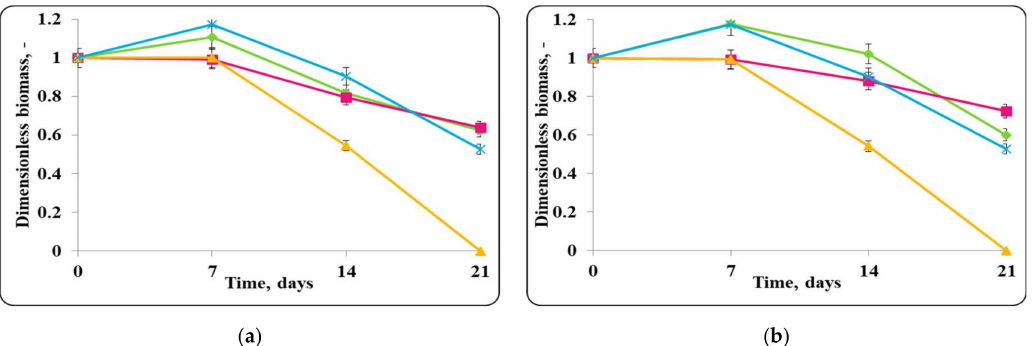
Figure 9. ( a ) free lactobacilli cells; ( b ) encapsulated lactobacilli cells. Changes in the total titratable acidity (TA) of MRS broth inoculated with Lb. helveticus 2/20 and E. coli ATCC 25922 during storage at 20 ± 2 ◦ C. Legend: Green (cid:117) : TA of MRS broth inoculated with Lb. helveticus 2/20; Pink (cid:4) : TA of MRS broth co-inoculated with Lb. helveticus 2/20 and E. coli ATCC 25922; Yellow (cid:78) : TA of MRS broth inoculated with E. coli ATCC 25922.